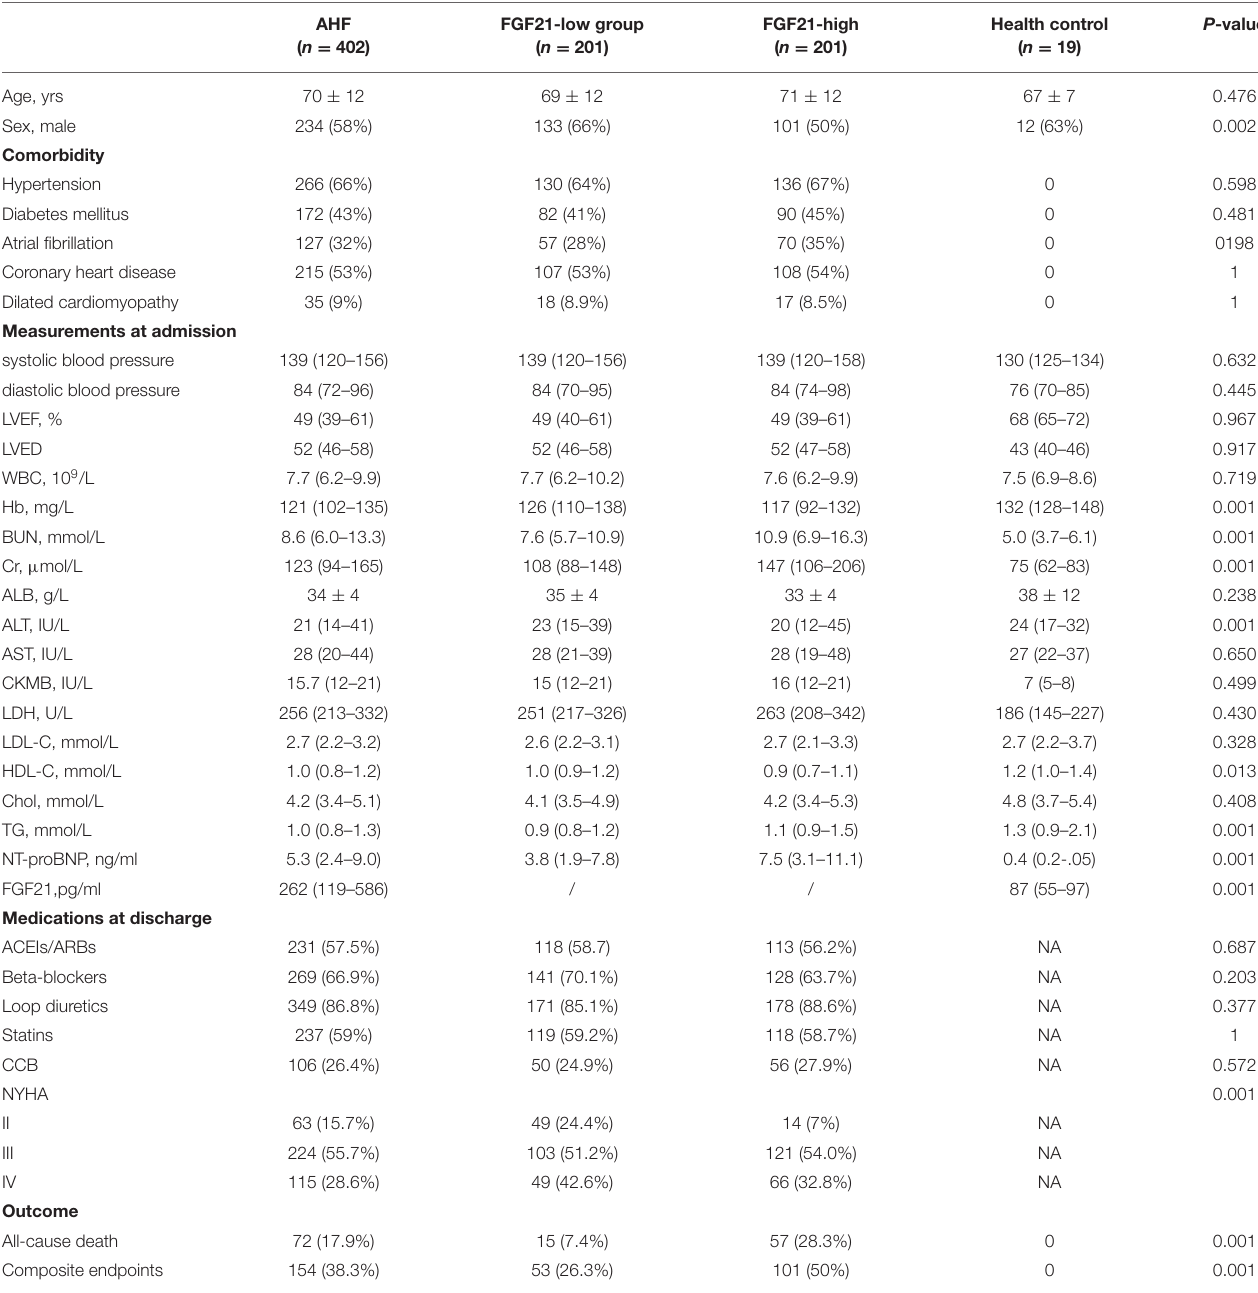
TABLE 1 | Baseline characteristics of the AHF cohort ( n =